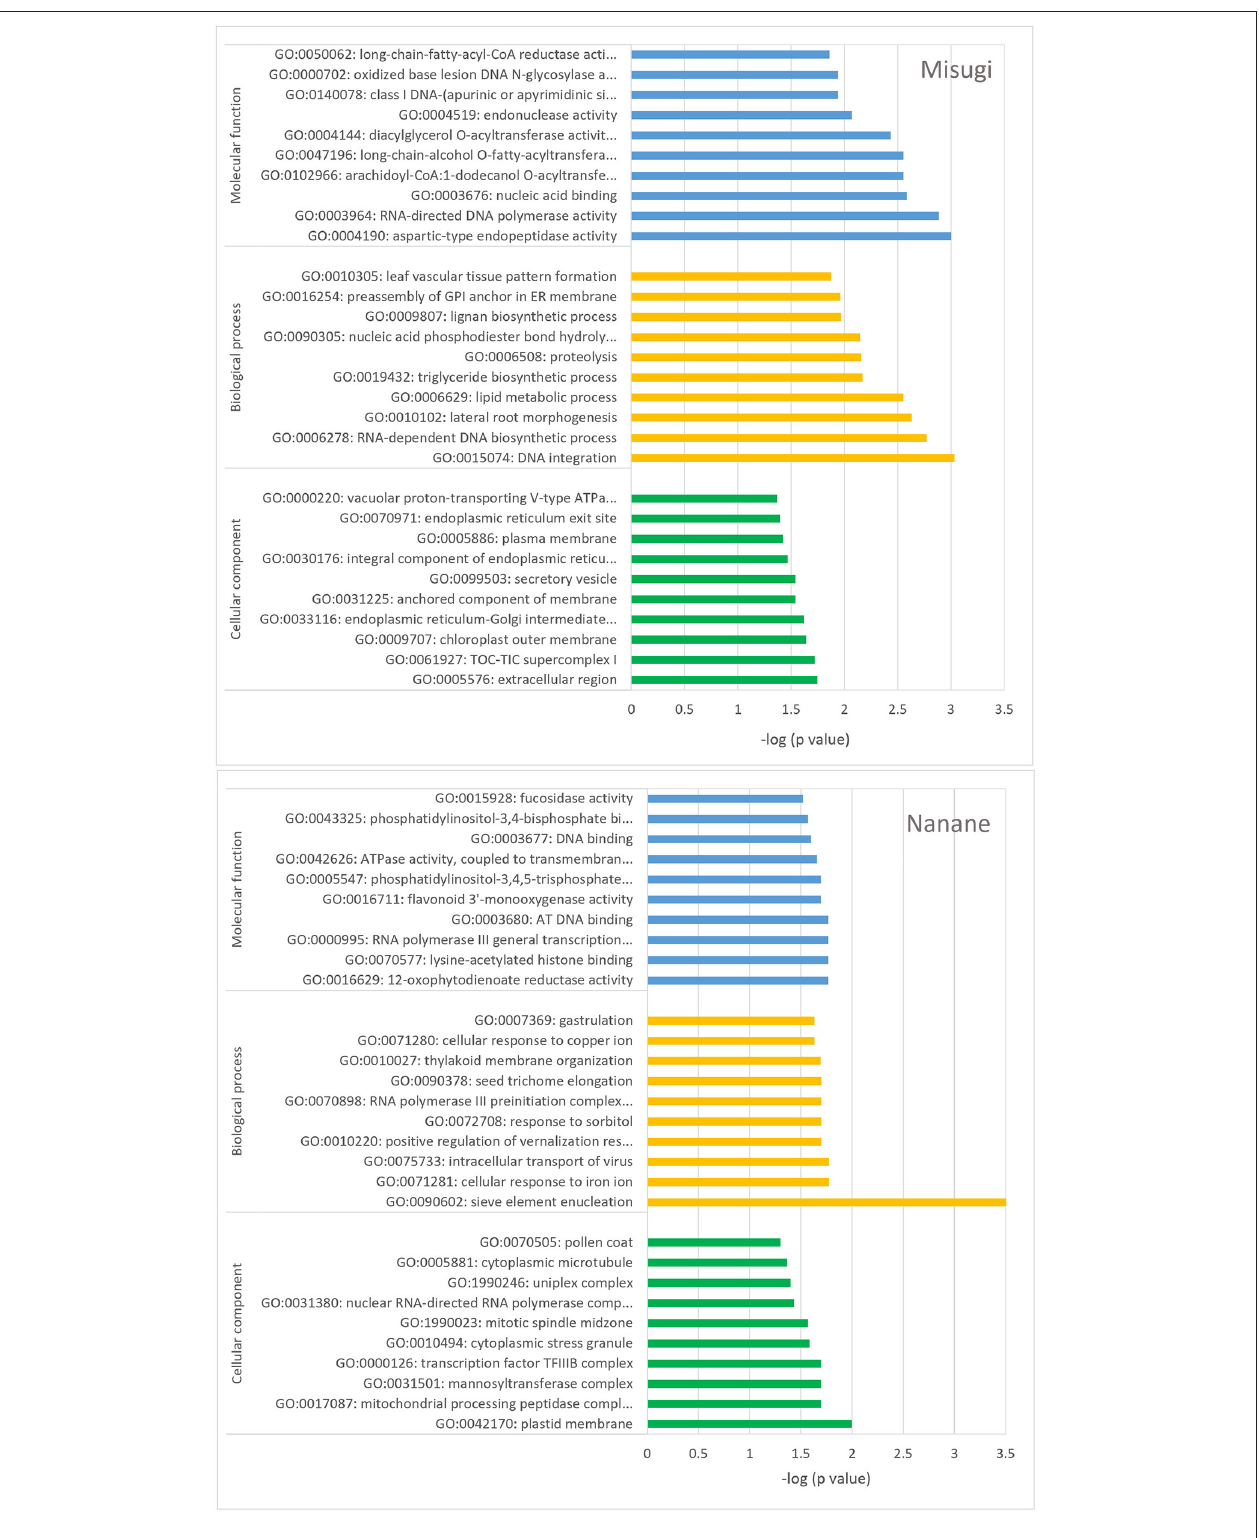
FIGURE 6 | Gene ontology (GO) enrichment analysis. Genes associated with differentially methylated regions (DMRs) between control cotyledons and cotyledons infected with A. candida , in B. rapa cultivars “Misugi” (susceptible, 136 genes) and “Nanane” (resistant, 178 genes) were used. The top 10 classes of three categories (biological process, molecular function, and cellular component) are exhibited.